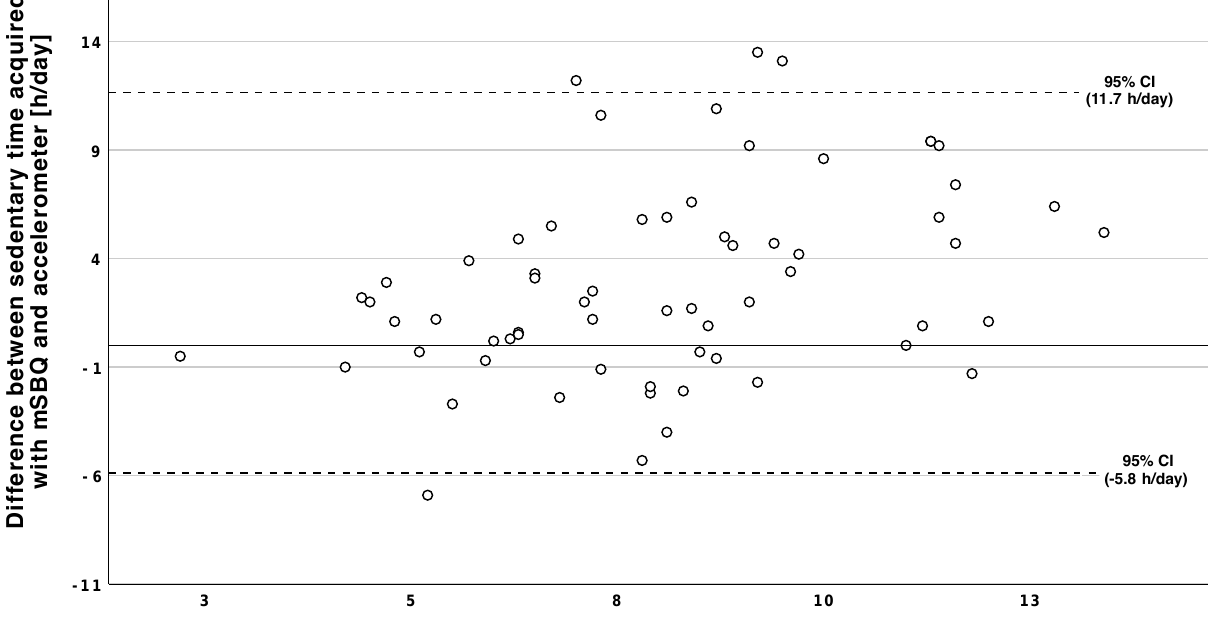
Average of sedentary time acquired with mSBQ and acceleromter [h/day] Figure 1. Bland-Altman plot. The solid line shows the mean difference between the sedentary time determined by the mSBQ and accelerometer data; the dashed lines represent the limits of agreement, i.e., the 95% confidence interval